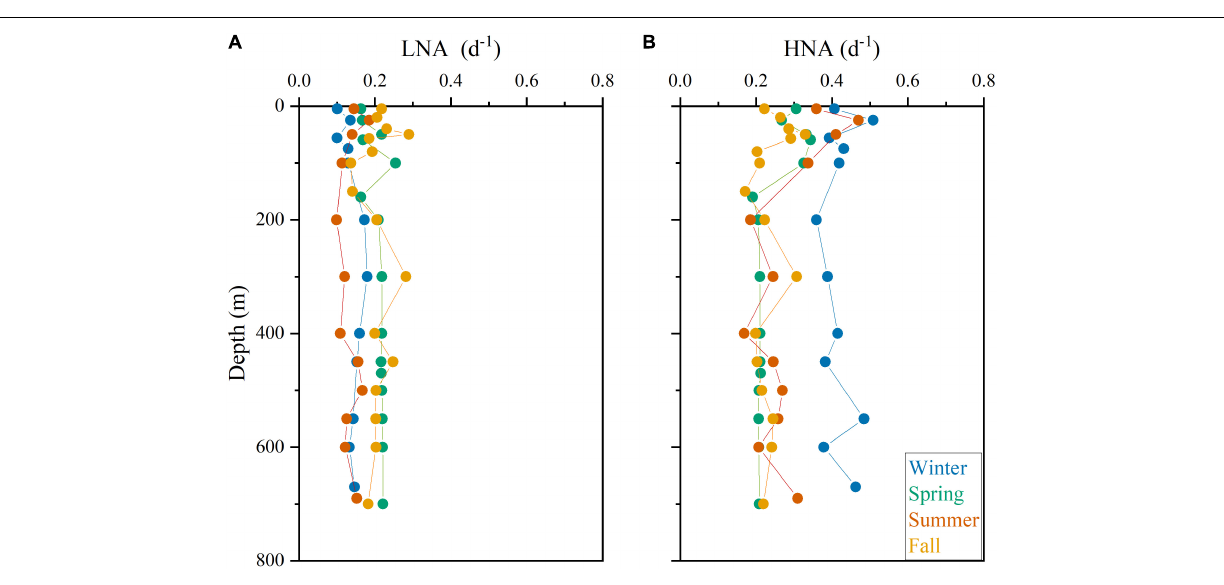
FIGURE 6 | Vertical profile of the estimated specific growth rates of low (LNA, A ) and high (HNA, B ) nucleic acid heterotrophic prokaryotes in the four sampling